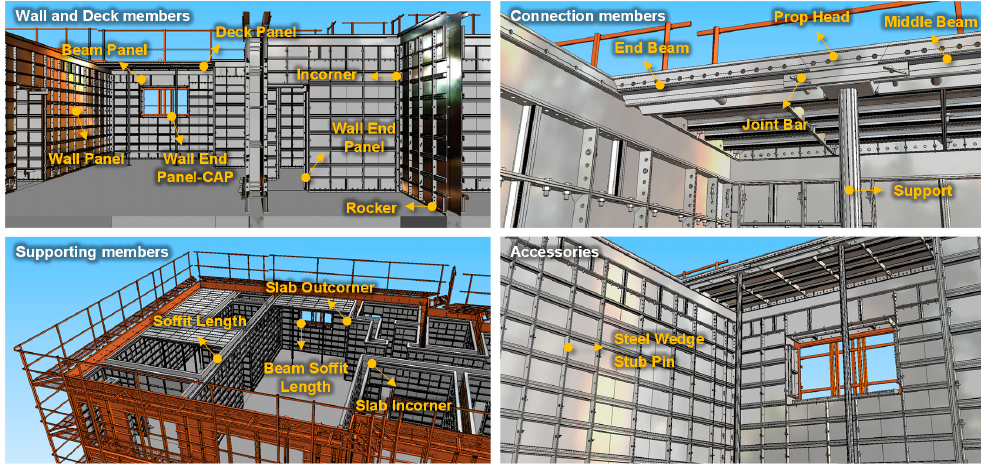
Figure 3. Aluminum formwork components.